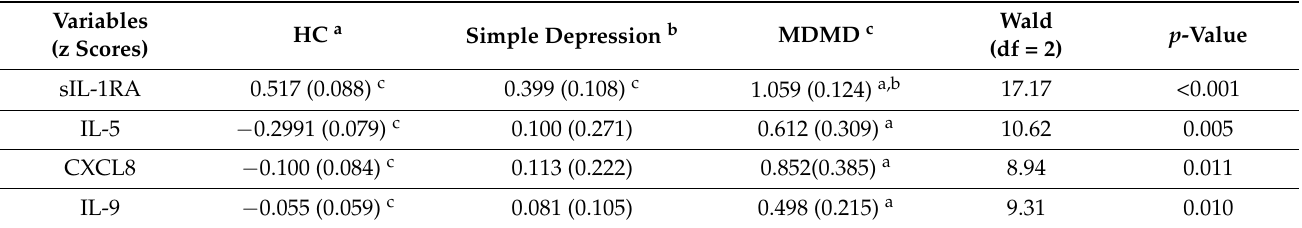
Table 3. Differences in lipopolysaccharide + phytohemagglutinin-stimulated changes in cy- tokines/growth factors in healthy controls (HC) and depressed patients, divided into those with simple depression and major dysmood disorder